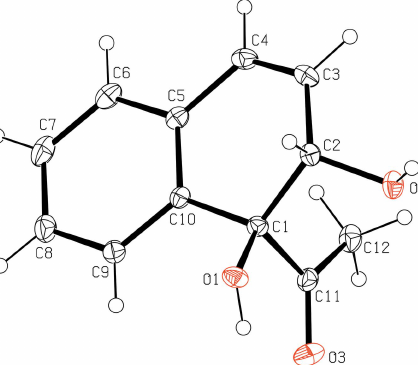
Figure 2 The molecular structure of the title compound with displacement ellipsoids drawn at the 30% probability